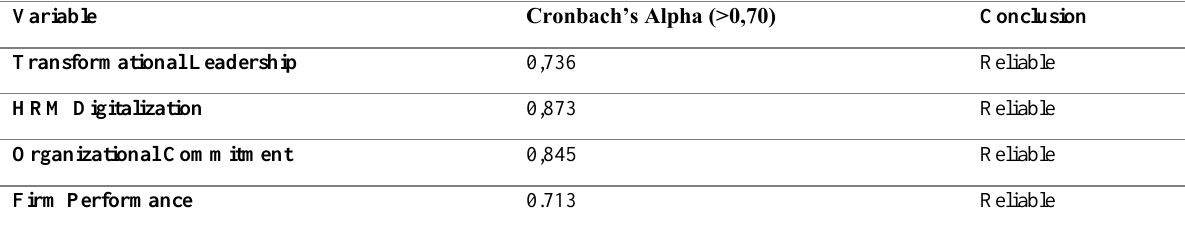
Table 1: Results of Reliability Test